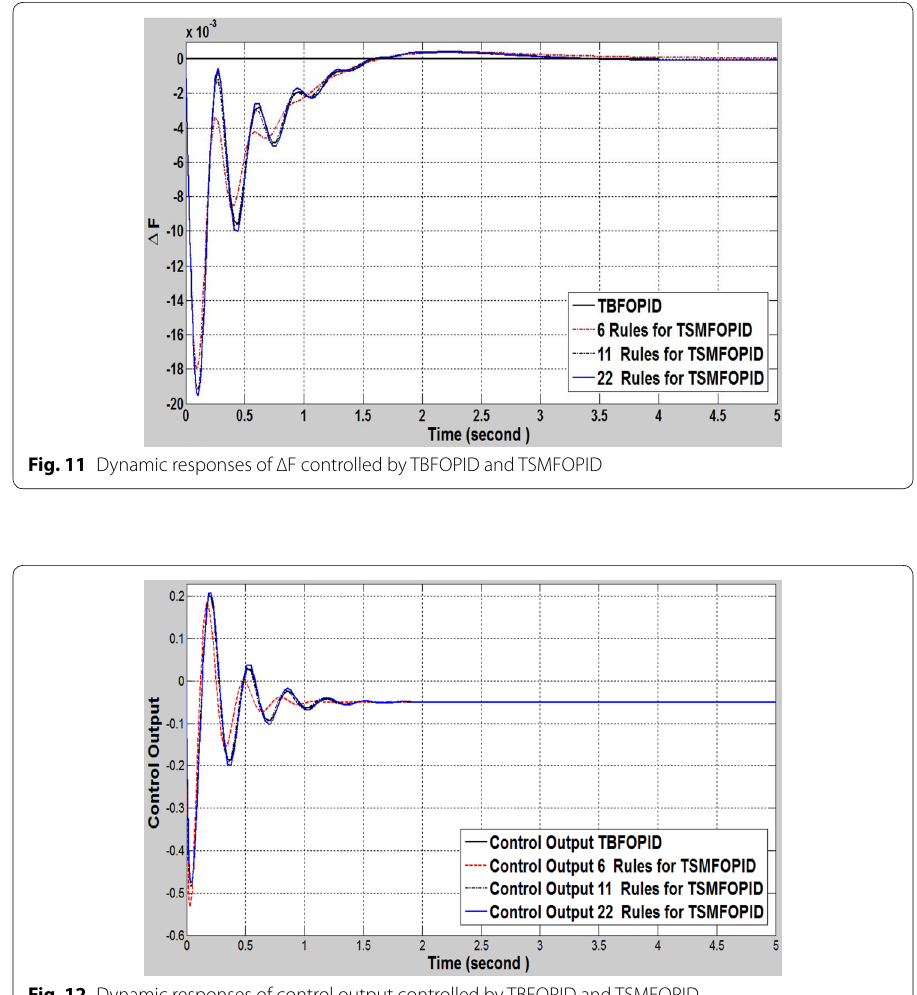
Fig. 12 Dynamic responses of control output controlled by TBFOPID and